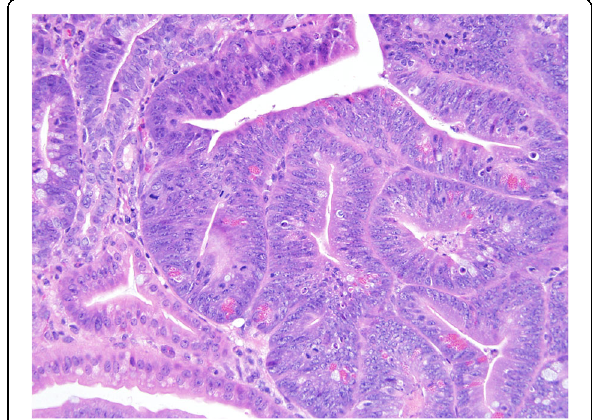
Fig. 7 Multiple cell types are present in adenomas in Apc Min/+ and related models. Here, scattered Paneth cells can be identified by their red cytoplasmic granules, and a few goblet cells are present in the adenoma. The predominant cell type is an absorptive